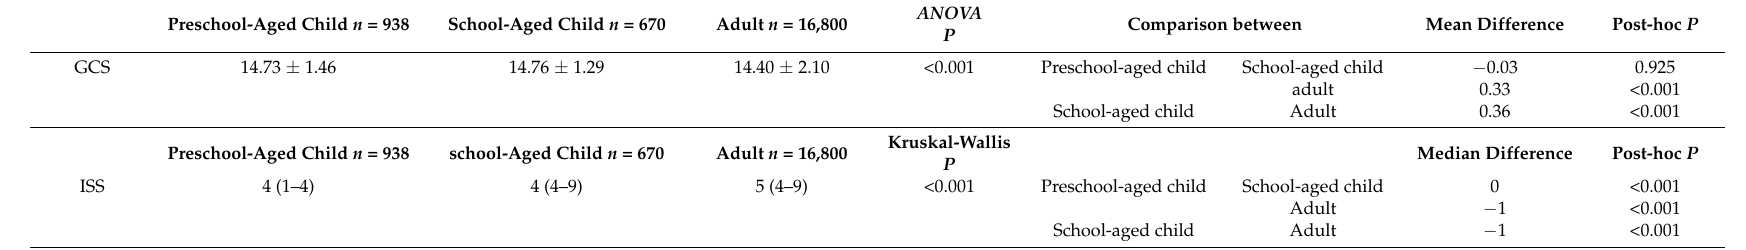
Table 2. Injury characteristics and outcomes of continuous variables in preschool-aged children, school-aged children, and adults.